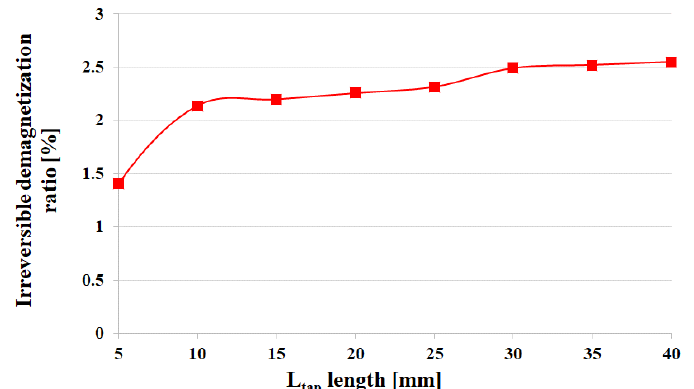
Figure 7. Irreversible demagnetization ratio depending on